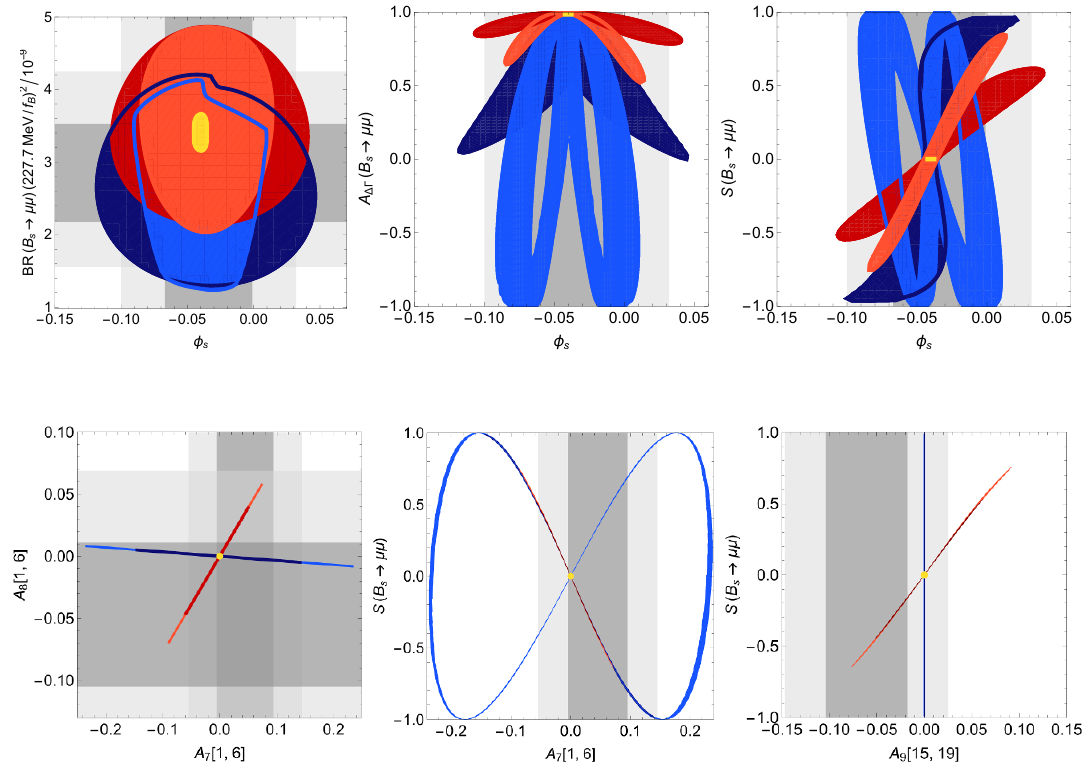
Figure 8. The correlations of observables in the b s sector in G SM -scenarios for M VLQ = ! 10 TeV [darker colours] and 1 TeV [lighter colours] within the 95% CL regions. The colours are for VLQ-representations D [Blue] (similar to T u;d ), Q V = Q d [Red]. Grey bands show experimental measurements at 1- and 2 (cid:27) and the yellow dots are the SM